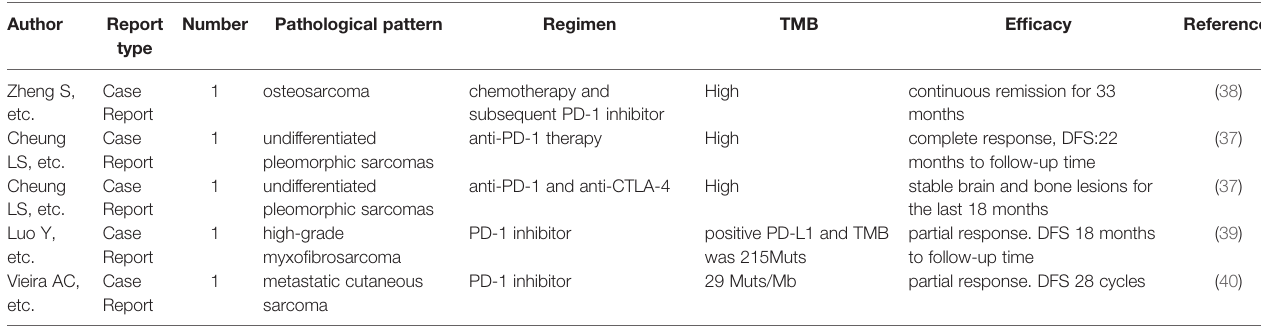
TABLE 2 | Ef fi cacy and TMB status in